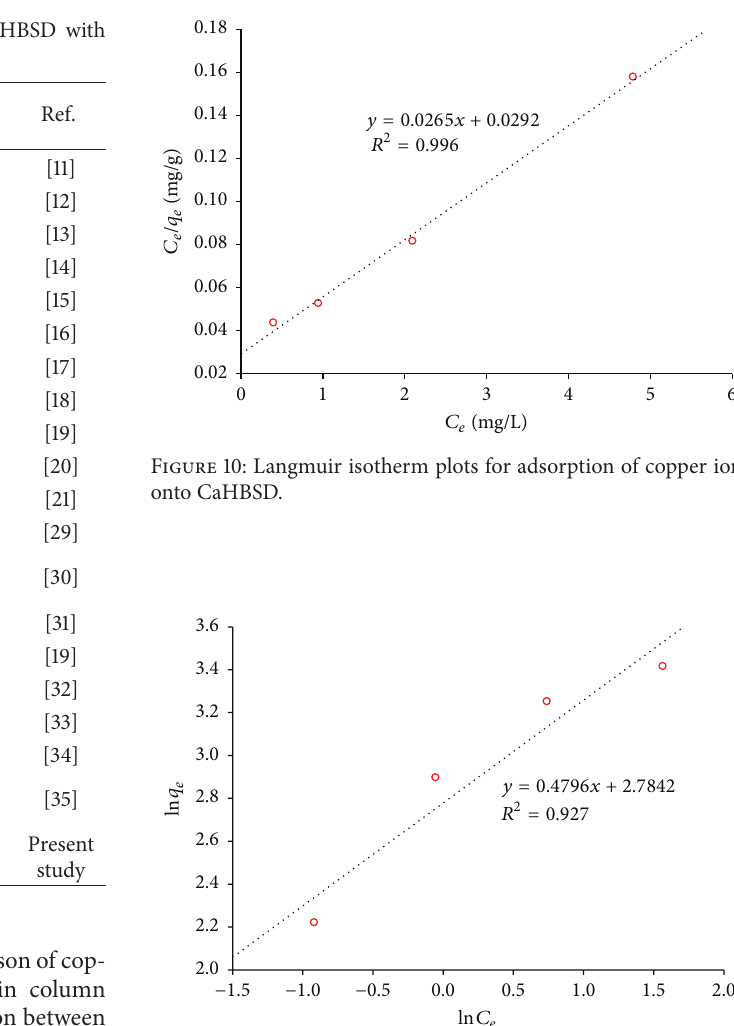
Figure 11: Freundlich isotherm plots for adsorption of copper ions onto CaHBSW.